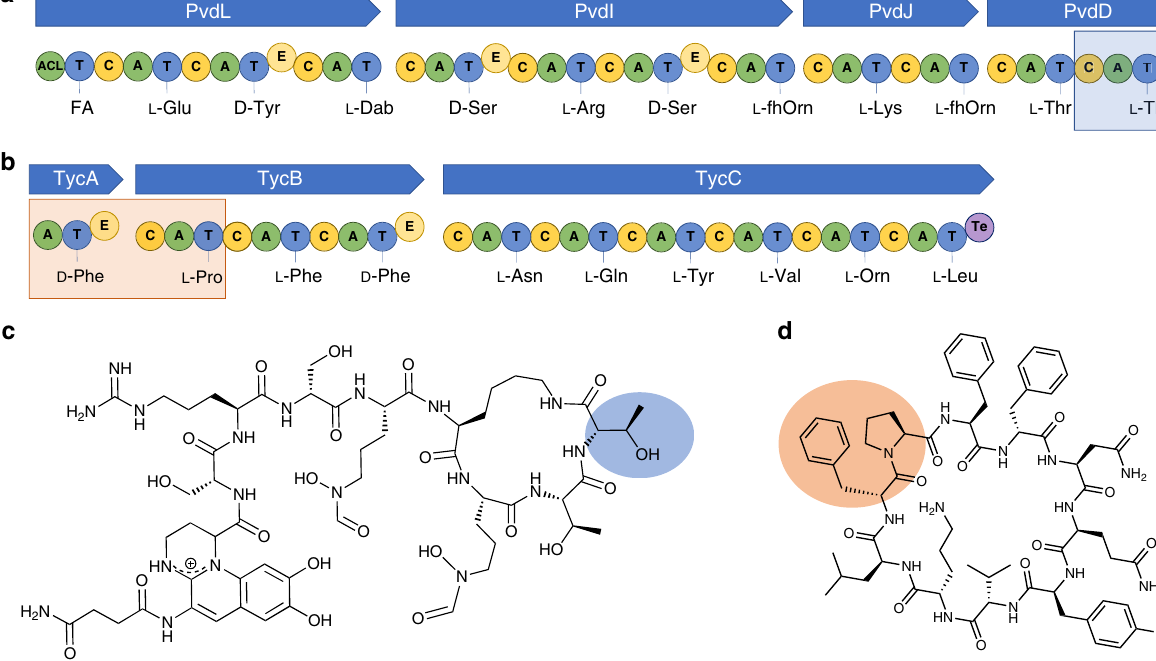
Fig. 1 NRPS assembly lines and products relevant to this work. Depicted are the biosynthetic gene clusters (blue arrows) and their encoded NRPS assembly lines involved in the biosynthesis of a pyoverdine and b tyrocidine, and the corresponding chemical structures for c pyoverdine and d tyrocidine. The NRPS module Pa11 is highlighted in blue in a , as is the corresponding L-Thr residue that it incorporates into pyoverdine in c . Likewise, the two modules that were extracted from the tyrocidine NRPS system by Belshaw et al. 3 and used to generate their PheATE/ProCAT model system are highlighted in orange in b , as are the D-Phe and L-Pro residues these incorporate into tyrocidine in d . NRPS domains are labelled as follow: ACL acyl-CoA ligase, C condensation, A adenylation, T thiolation, E epimerisation, and Te thioesterase. The following non-standard amino acid abbreviations are used: Dab, 2,4- diaminobutyric acid; fhOrn, N 5 -formyl-N 5 -hydroxyornithine; Orn,